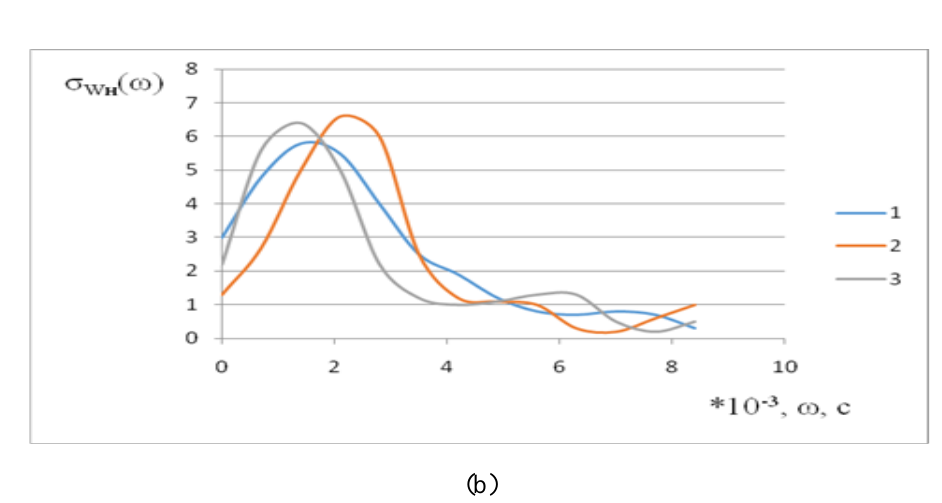
Figure 3. Correlation function (a) and spectral density (b) of the process of changing the initial grain moisture.